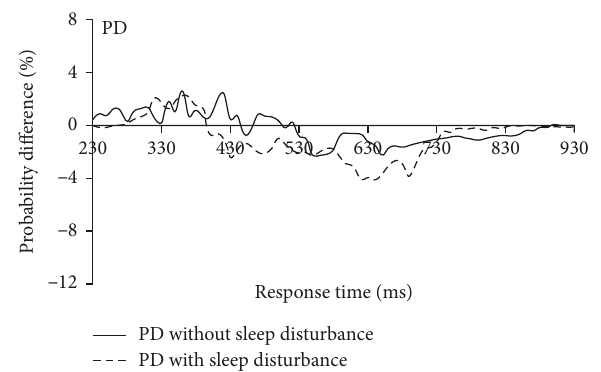
Figure 5: Direct comparison of audiovisual performance relative to the predicted race model. No significant audiovisual integration was found in both PD with sleep disturbance group (dotted line) and without sleep disturbance group (solid